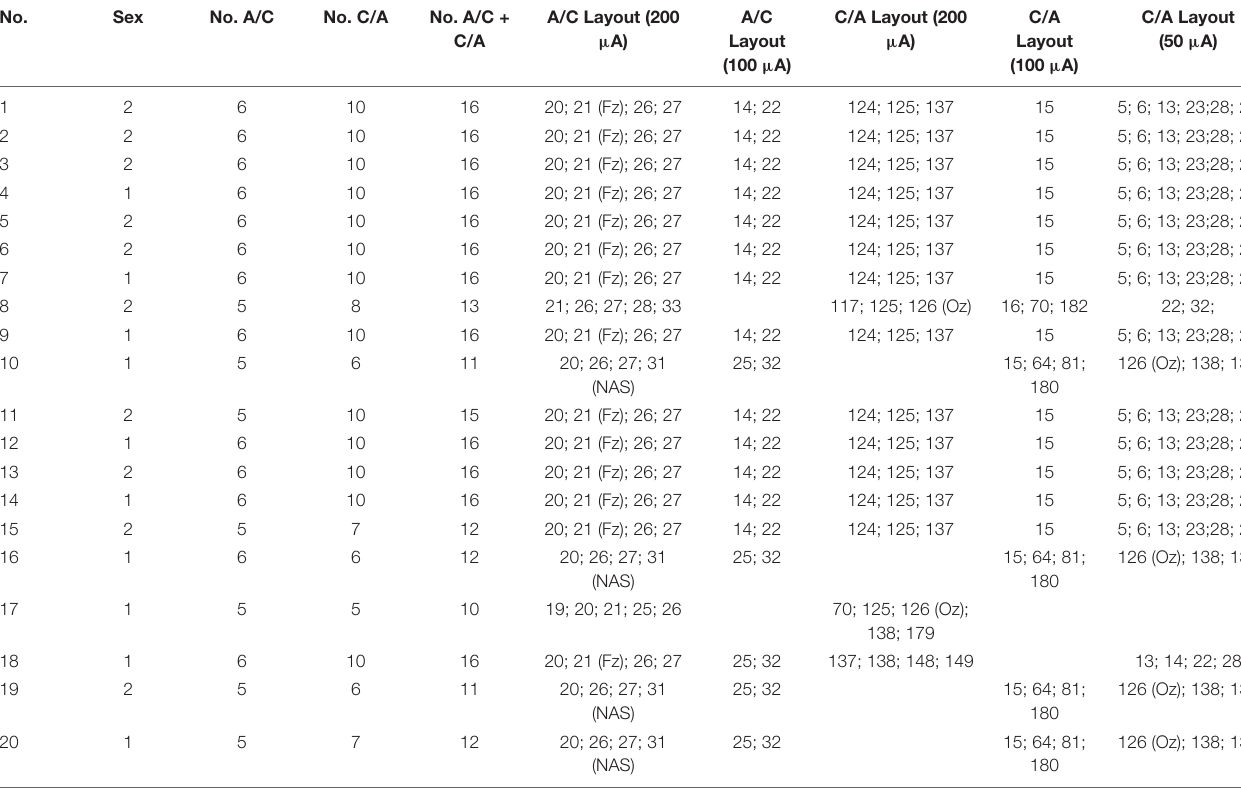
TABLE 1 | The specification of electrode layouts (256-channel HydroCel Geodesic Sensor Net), including the number of electrodes, their position, and current intensity in each electrode used for individualized HD θ -tACS in subjects.